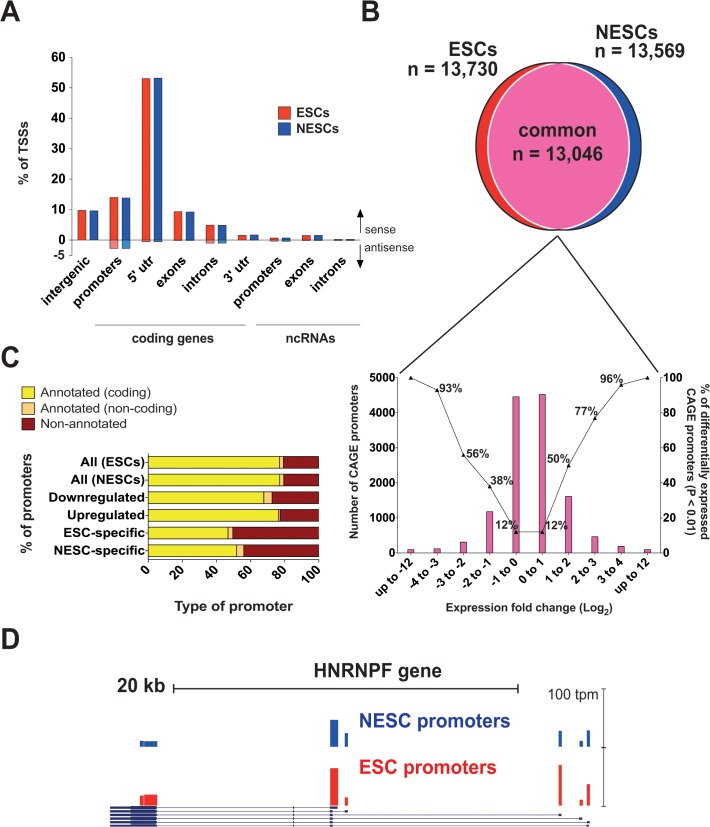
Differential Pol-II promoter usage during differentiation of ESCs to NESCs.A) CAGE mapping of transcription start sites (TSSs) to intergenic regions or to promoters (500 bp around the RefSeq TSS), 5’ UTRs, exons, introns and 3’ UTRs of protein-coding and non-coding RefSeq transcripts annotated on the hg19 assembly of the human genome. Bars indicate the percentage of each category of CAGE-defined TSSs in the sense (above the X axis) or anti-sense (below the X axis) transcriptional orientation with respect to the annotated transcript. B) Venn diagram showing the fraction of common and cell-specific CAGE promoters mapped in ESCs and NESCs. For the common promoters, a histogram indicates the number of promoters (left Y axis) distributed in different categories of differential expression during ESC neural induction, with FC from -12 to 0 (down-regulated promoters) and from 0 to +12 (up-regulated promoters). For each category, the fraction of promoters differentially expressed at a statistically significant level (χ2 test, p ≤0.01) is indicated (right Y axis). C) Proportion of all, cell-specific, upregulated and down-regulated CAGE promoters annotated to RefSeq protein-coding (yellow) or non-coding (light brown) genes. The fraction of unannotated promoters is shown in dark brown, and significantly increases in the regulated and cell-specific categories. D) Example of a gene (HNRNPF) associated to multiple alternative promoters in both cell types. All 5 known HNRNPF promoters were mapped in ESCs (red bars) and NESCs (blue bars) by CAGE-seq, which identified also two novel promoters in the last exon of the gene. The height of the bars reflects the promoter strength expressed in tpm (scale on the right).